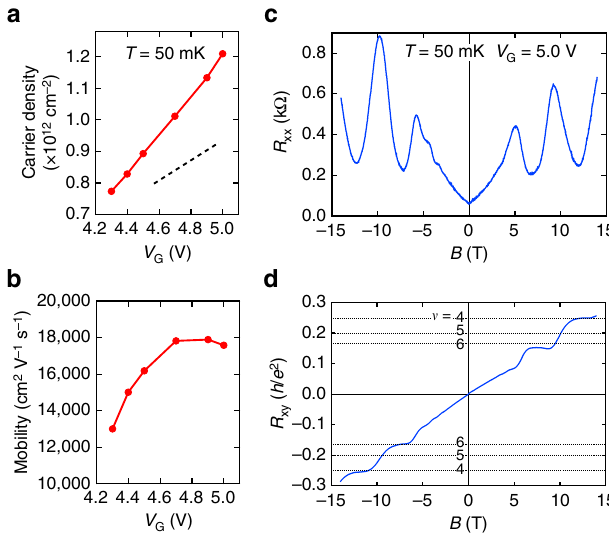
Figure 2 | Transport properties of two-dimensional electrons in d -doped SrTiO 3 . ( a , b ) Carrier density ( a ) and mobility ( b ) as a function of gate voltage V G at 50mK. The slope depicted as broken line, 2.8 (cid:3) 10 11 cm (cid:2) 2 V (cid:2) 1 , denotes the calculated one for the carrier density against gate voltage, assuming a STO gate dielectric constant e of 20,000. ( c , d ), Longitudinal resistance R xx ( c ) and Hall resistance R xy ( d ) versus magnetic field B measured at 50mK with V G ¼ 5.0V. Horizontal dotted lines in ( d ) are the Landau level filling factors ( n ) defined as R xy ¼ h / n e 2 ( n ¼ 4, 5, 6). NATURE COMMUNICATIONS|7:11631|DOI: